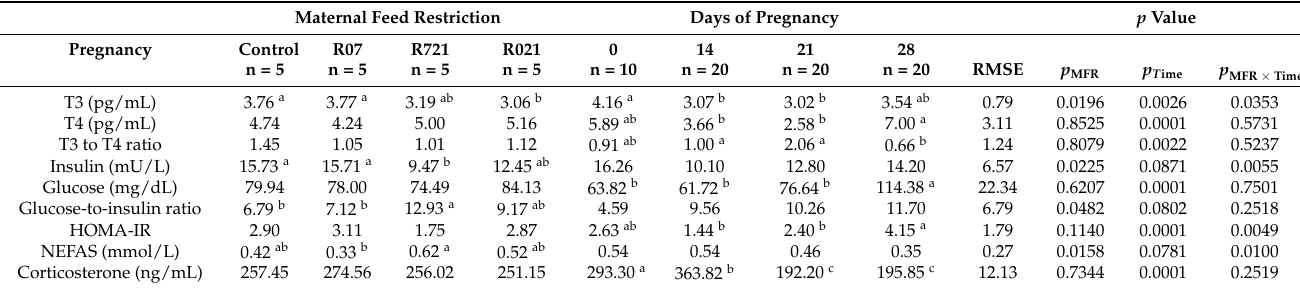
Table 4. Effect of maternal feed restriction (MFR) and time on endocrine and metabolic parameters during pregnancy of rabbits fed ad libitum (Control), restricted to 60% one week from day 0 to 7 (R07), two weeks from day 7 to 21 (R721) and three weeks from day 0 to 21 (R021) of